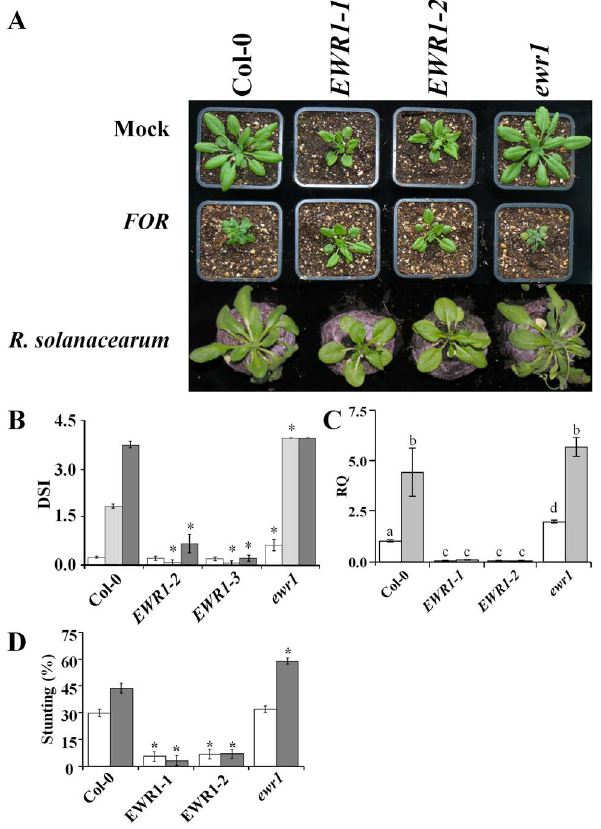
Figure 4. EWR1 over-expression provides resistance to other vascular wilt pathogens. (A). typical disease symptoms caused by Fusarium oxysporum f.sp. raphani ( FOR ) and R. solanacearum on the wild-type (Col-0), two EWR1 expressing plants (EWR1-1 and EWR1-2) and the EWR1 knock out line ( ewr1 ) at 12 ( F. oxysporum ) and 5 ( R. solanacearum ) days post inoculation (dpi). The experiment was repeated at least three times and representative of the three replications is shown. (B) Disease severity index (DSI) scores upon inoculation of at least 21 plants with R. solanacearum on a scale of 0 (no infection) to 4 (all rosette leaves diseased) at 3 (white bar), 6 (light grey bar) and 10 (dark grey bar) dpi. Bars represent averages with standard deviation of three independent biological replicates and asterisks indicate significant differences ( p =0.05). (C) Relative quantification (RQ) by real-time PCR of R. solanacearum colonization in wild-type (Col-0), two independent EWR1 over-expressing lines (EWR1-1 and, EWR1-2), and of the EWR1 knockout line ( ewr1 ) by comparing levels of the R. solanacearum endoglucanase gene (as measure for Ralstonia biomass) relative to levels of the large subunit of the Arabidopsis RubisCo gene (for equilibration) at 3 and 5 dpi. Bars represent averages with standard deviation of four technical replicates and a representative of three independent experiments is shown. (D) Fusarium-induced stunting of wild-type (Col-0) plants, two independent EWR1 over-expression lines (EWR1-1 and, EWR1-2) and of the EWR1 knockout line ( ewr1 ) at 10 and 14 dpi. Rosette diameters of inoculated plants were compared with those of mock-inoculated plants. The bars represent averages of two independent experiments with standard deviation and asterisks indicate significant differences (Dunnett t-test at P=0.05 ). (E) Relative quantification (RQ) of EWR1 transcription in wild-type (Col-0) plants, two independent EWR1 over-expressing plants (EWR1-1 and EWR1-2), the A2 mutant, and of the EWR1 knock out line ( ewr1 ). Bars represent averages with standard deviation of three biological replicates.